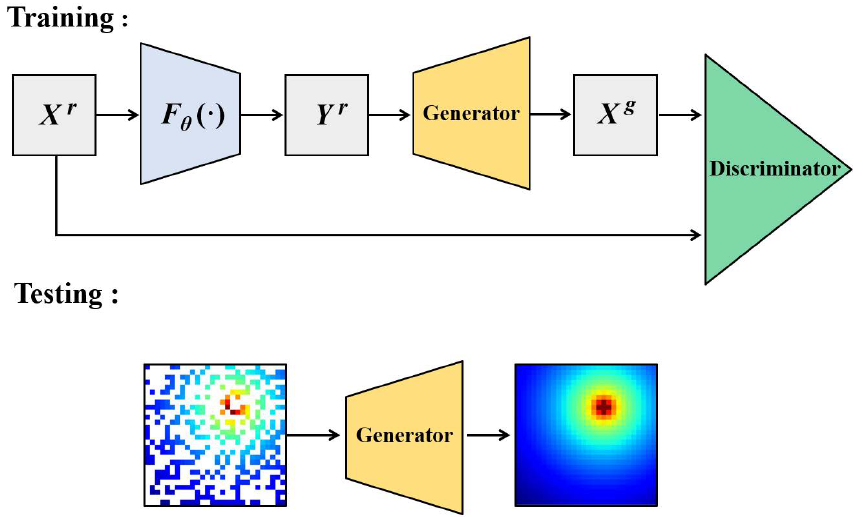
Figure 4. Maps estimation GANs